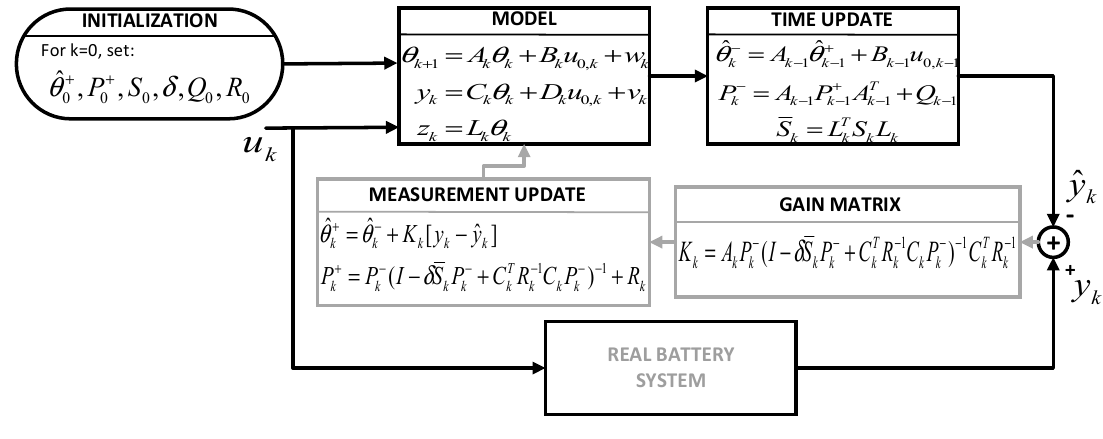
Figure 11. H-infinity filter algorithm.